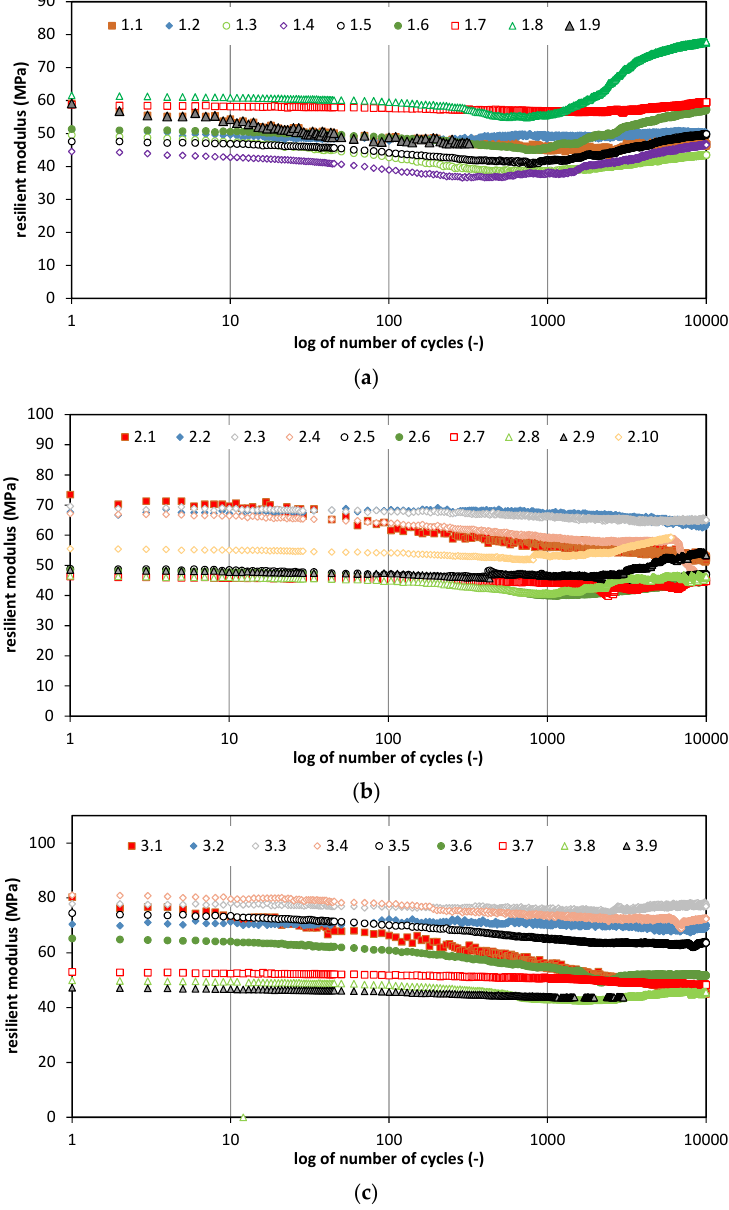
Figure 8. Resilient modulus value of tested sandy clay for different conditions: radial stress σ ’ 3 equal to ( a ) 45 kPa; ( b ) 90 kPa; and ( c ) 135 kPa, as defined in Table 2.